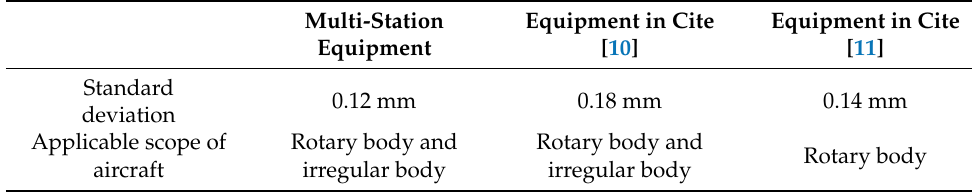
Table 3. Comparison of 3 self-compensating centroid measuring